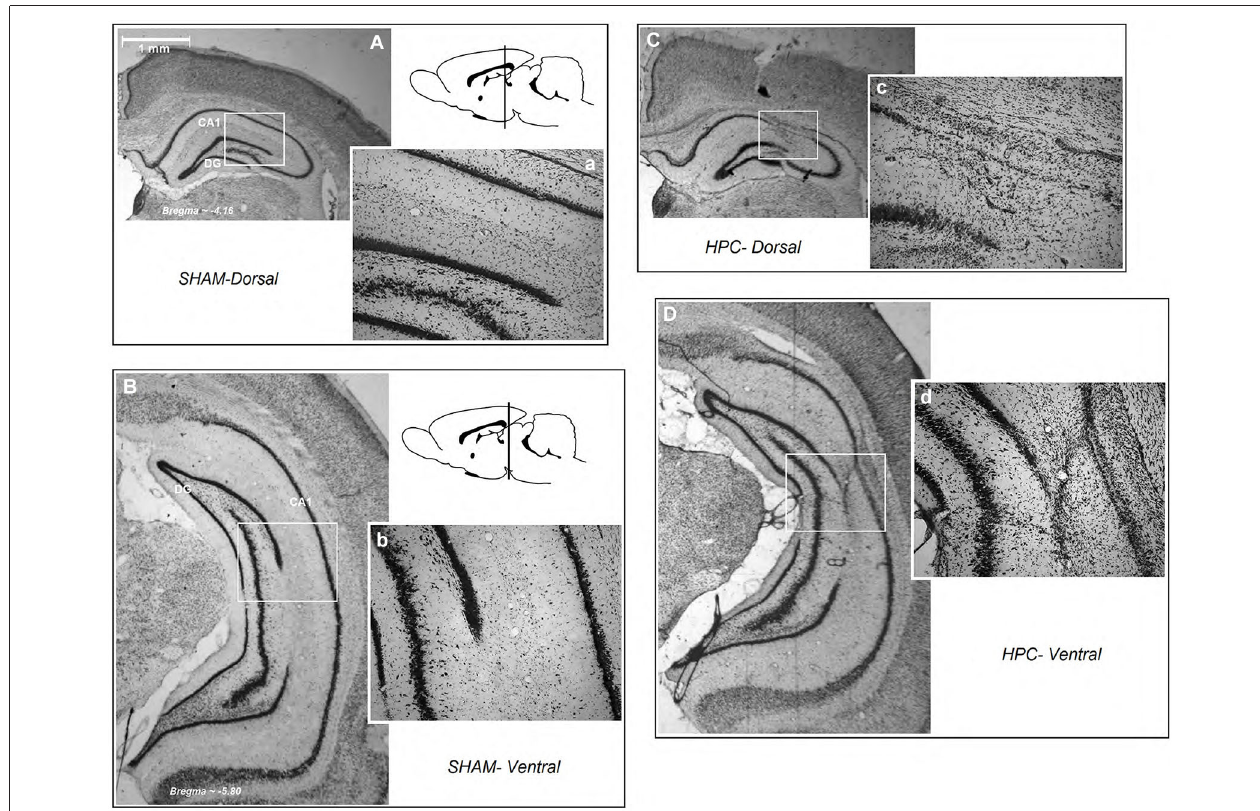
a vHPC rat. Both low and higher magnifications of the dorsal and ventral hippocampus show that all ischemic rats displayed similar tissue loss resulting from ET-1 infusion. HPC-D: dorsal hippocampus; HPC-V: ventral